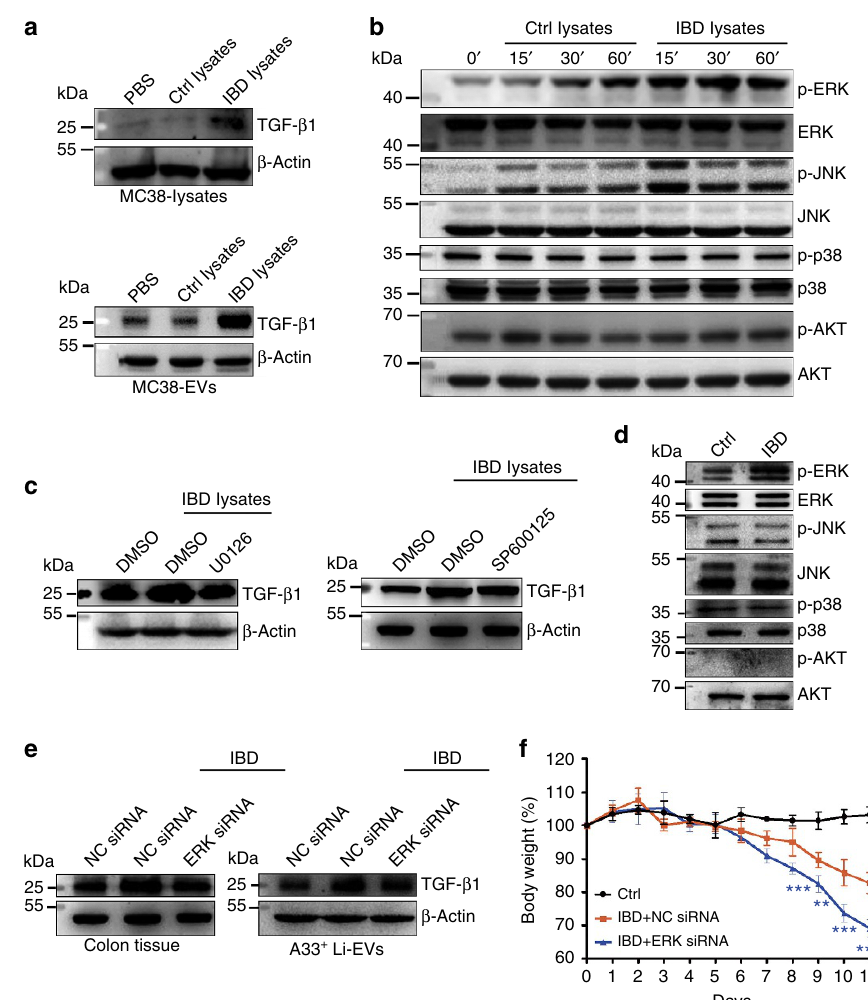
Figure 7 | ERK and TGF- b 1 levels in IBD-A33 þ Li-EVs. ( a ) MC38 cells were treated with 1mgml (cid:2) 1 IBD lysates or Ctrl lysates for 24h. TGF- b 1 in MC38 cells or MC38-EVs was measured using western blot analysis. ( b ) MC38 cells were treated with 1mgml (cid:2) 1 IBD lysates or Ctrl lysates for the indicated times. Activation of ERK, JNK, p38 and ATK in MC38 cells was measured using western blot analysis. ( c ) MC38 cells were pretreated with DMSO, 10 m M ERK-specific inhibitor U0126 or JNK-specific inhibitor SP600125 for 30min and then treated with 1mgml (cid:2) 1 IBD lysates or Ctrl lysates for 24h. TGF- b 1 in MC38-EVs was measured by western blot analysis. ( d ) Activation of ERK, JNK, p38 and ATK in colon tissues from healthy control or IBD mice was measured using western blot analysis. ( e , f ) Mice were fed with 2% DSS solution on day 0. Mice received intrarectal injection with 20 m g cholesterol- conjugated ERK or NC siRNA every other day on days 0–11. Twenty-four hours after the last injection, mice were killed. TGF- b 1 in colon tissues and A33 þ Li-EVs was measured using western blot analysis ( e ). The body weights of mice were measured daily ( f ). Ctrl group, mice that received normal drinking water. ( a – e ) Data are representative of three independent experiments; ( f ) data are presented as the mean ± s.d. from one of the two independent experiments ( n ¼ 5 per group). P values were generated by two-way ANOVA, followed by Newman–Keuls multiple comparison test using GraphPad